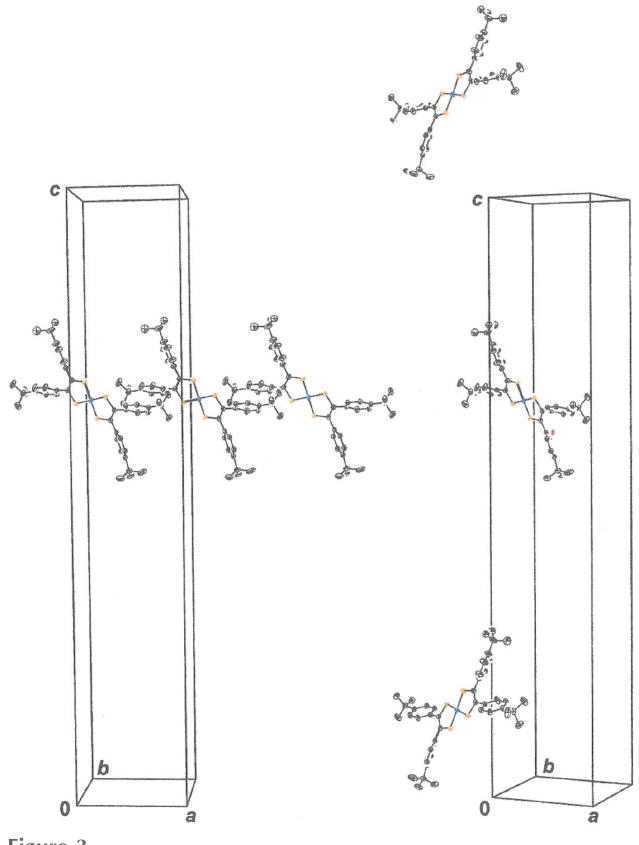
Figure 3 Molecules of 1 related by translations along the a axis (left side). Molecules of 1 related by the 2 1 screw axis operation along c (right side). Displacement ellipsoids are drawn at the 50% level, and all H atoms are omitted for